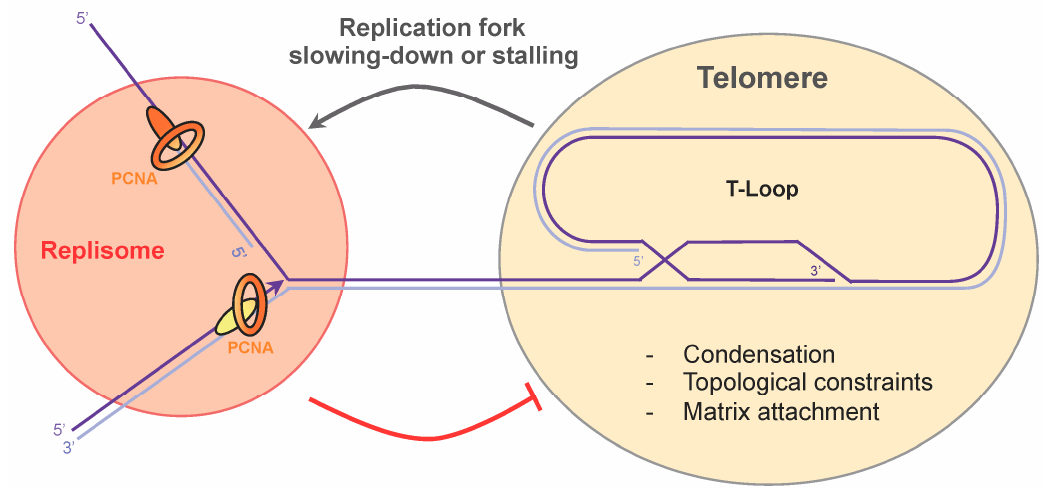
Figure 4. Replication fork passage through the telomeric repeat sequences. Topological constraints, condensation, and attachment to the nuclear matrix impede replication fork progression at telomeres. Cross-talk between the replisome and shelterin may take place to promote telomere decompaction and replication fork slowing-down.